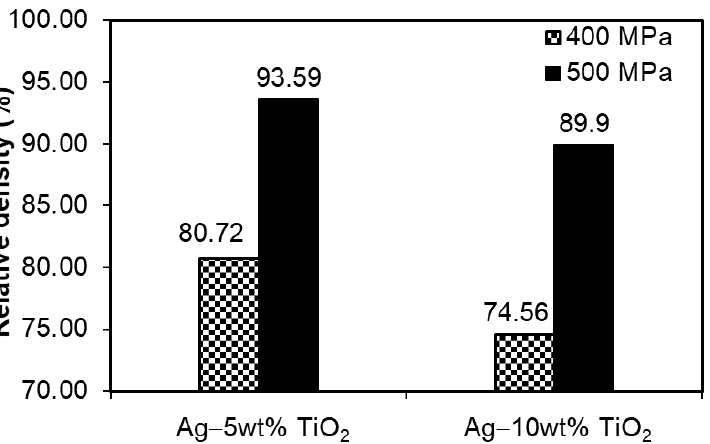
Figure 3. Relative densities of as-sintered PM silver matrix composites depending on chemical composition and process parameters (Archimedes method).